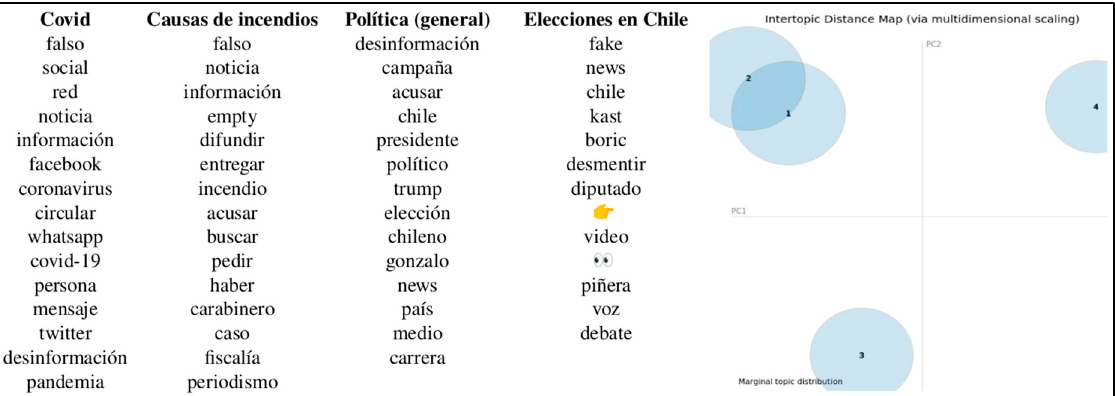
Figure 3. Top words and projection in the main foreground of the four topics obtained with